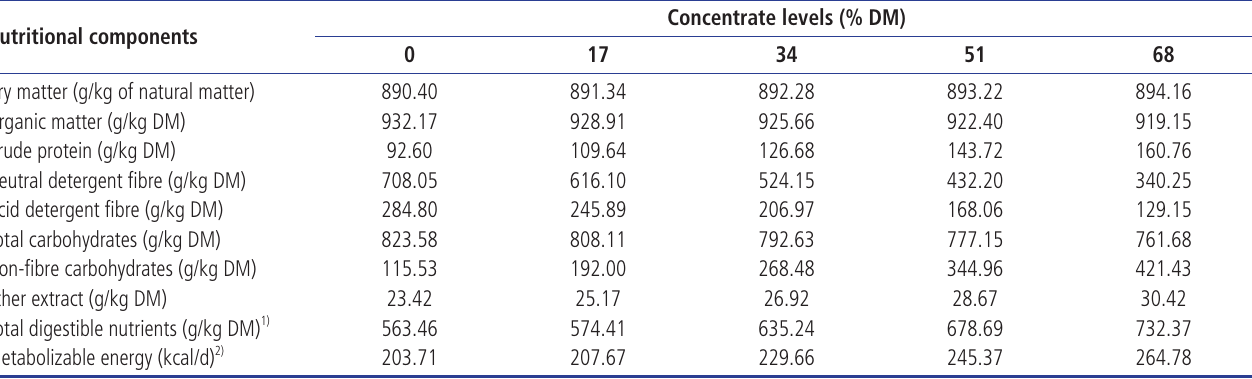
Table 1. Chemical composition of experimental diets Nutritional